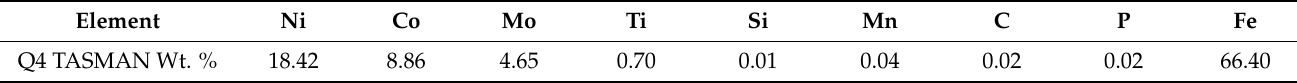
Table 1. Chemical composition of fabricated samples using